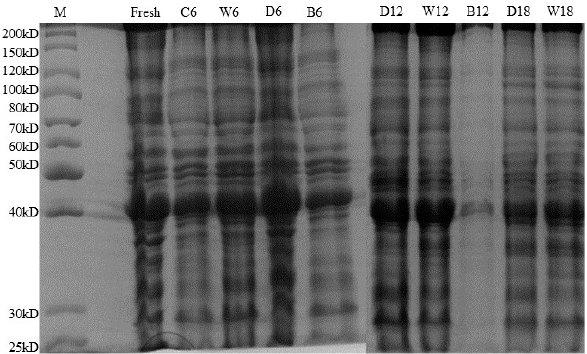
Figure 9. Effect of the SDS-PAGE profile of beef myofibril stored in different low-temperature storage